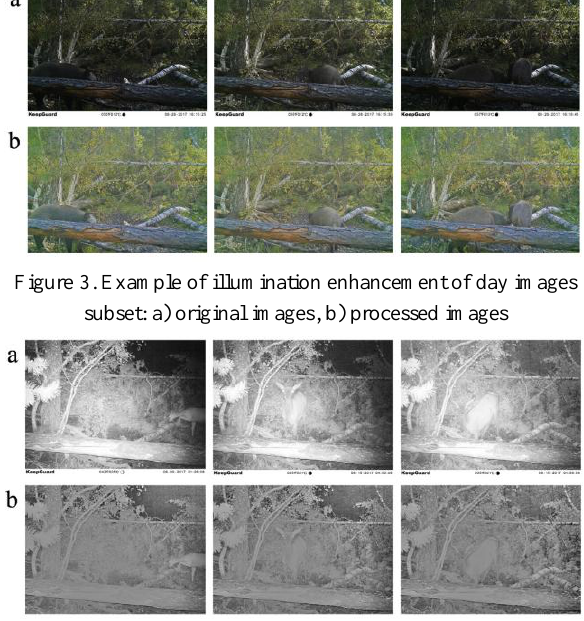
Figure 4. Example of illumination enhancement of night images subset: a) original images, b) processed images